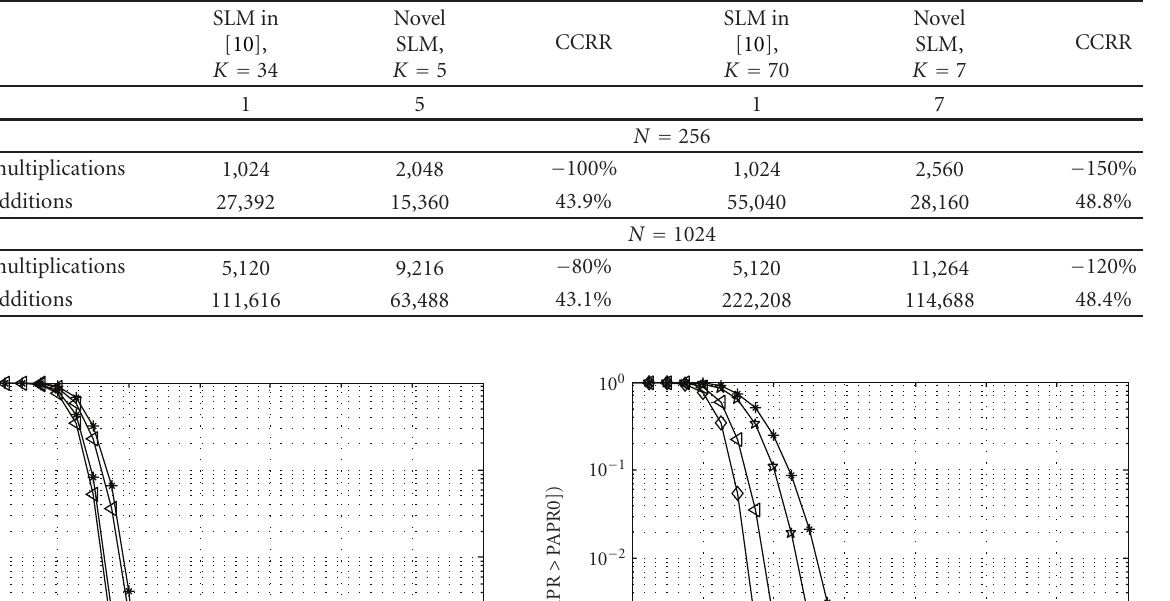
Table 3: Computational complexity of the SLM schemes in [10] and the novel SLM schemes when N = 256 and 1024.